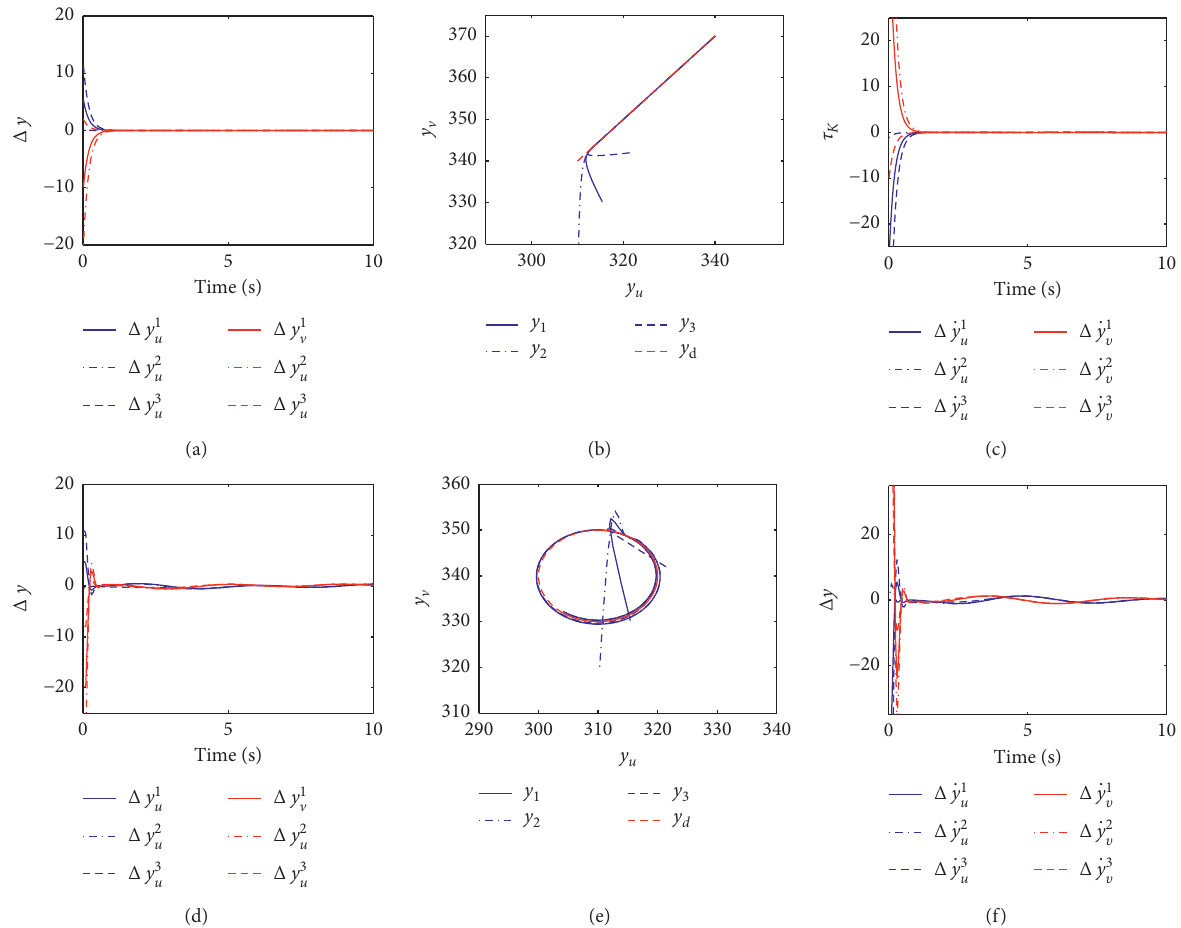
Figure 3: Control responses of AVSDC schemes. (a) Position errors on image plane in TLC. (b) The real and desired trajectory in TLC. (c) Velocity errors on image plane in TLC. (d) Position errors in TCC. (e) The real and desired trajectory in TCC. (f) Velocity errors on image plane in